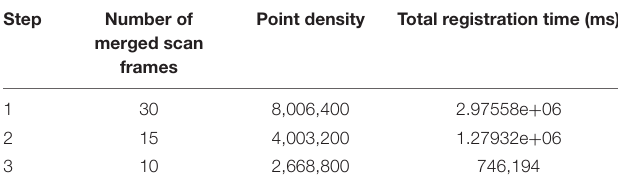
TABLE 4 | Registration performances of three different steps.